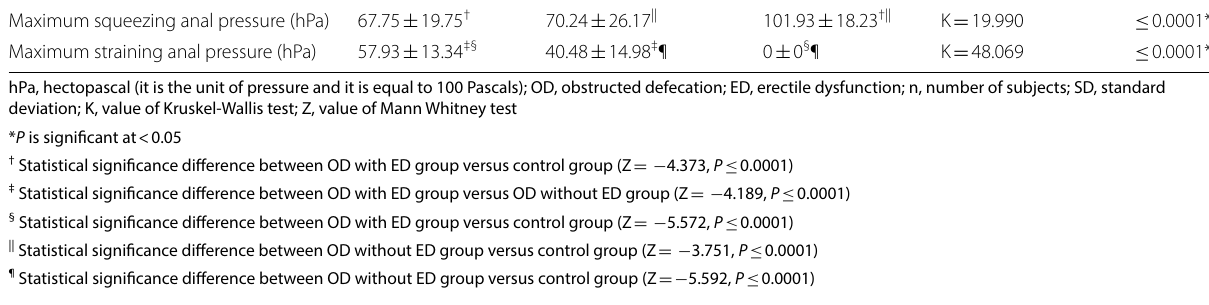
Table 2 Anal manometric parameters of the two patient groups and control group